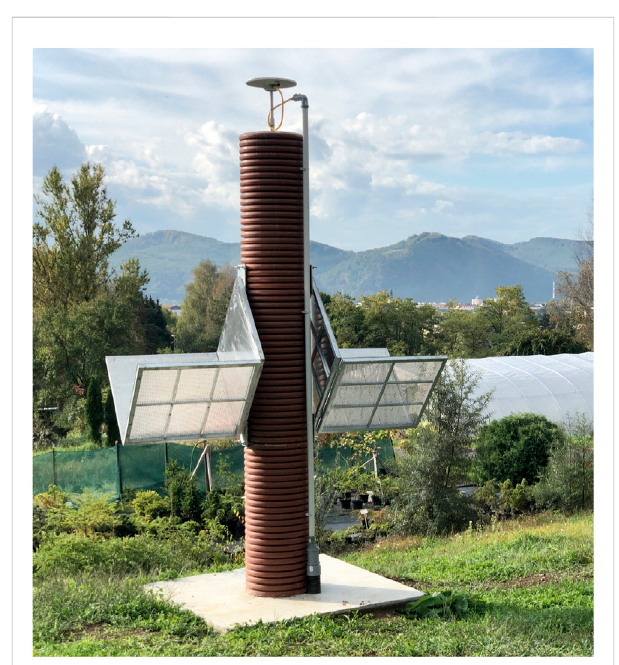
FIGURE 11 The new type of InSAR and GNSS co-location reference station (ZVOL) of the permanent SKPOS network (SKPOS